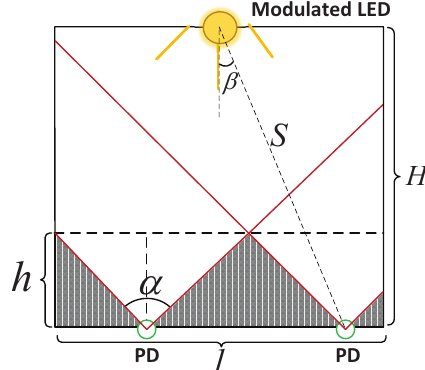
Figure 7. 2D plan of the mine cage, where the shaded parts indicate the perception blind zone of photodiodes